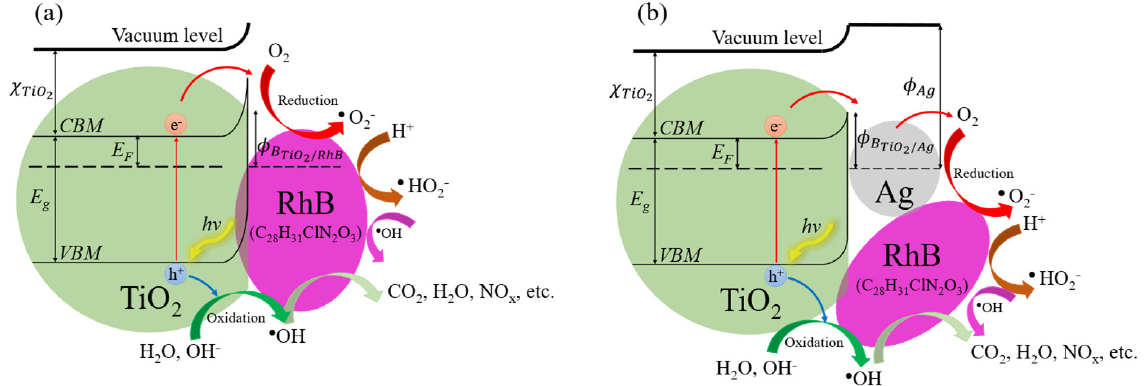
Figure 7. The photodegradation of RhB in an aqueous solution using TiO 2 ( a ) and AgNP/TiO 2 ( b ) as a photocatalyst. CBM— conduction band minimum; VBM— valence band maximum; E g —energy — electron affinity; h ν —photon energy; e ⁻ —electron; h + — band gap; E F —Fermi energy level; 𝜒 (cid:3021)(cid:3036)(cid:3016) (cid:3118) hole.